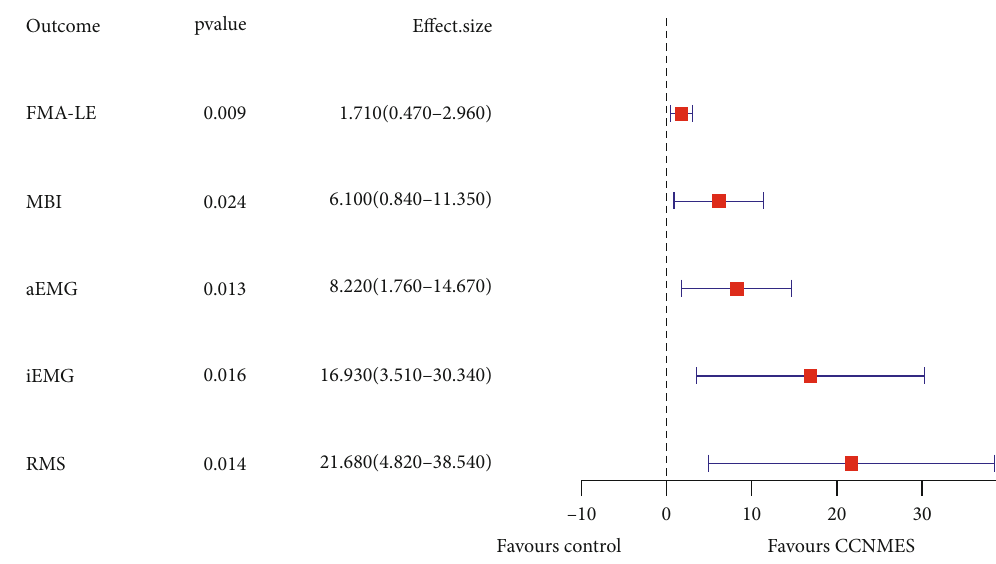
Figure 3: Forest plot presenting the treatment e ff ects of CCNMES and NMES on the di ff erent parameters assessed. FMA-LE: Fugl – Meyer assessment-lower extremity; MBI: modi fi ed Barthel index; aEMG: average electromyography; iEMG: integrated electromyography; RMS: root mean square.